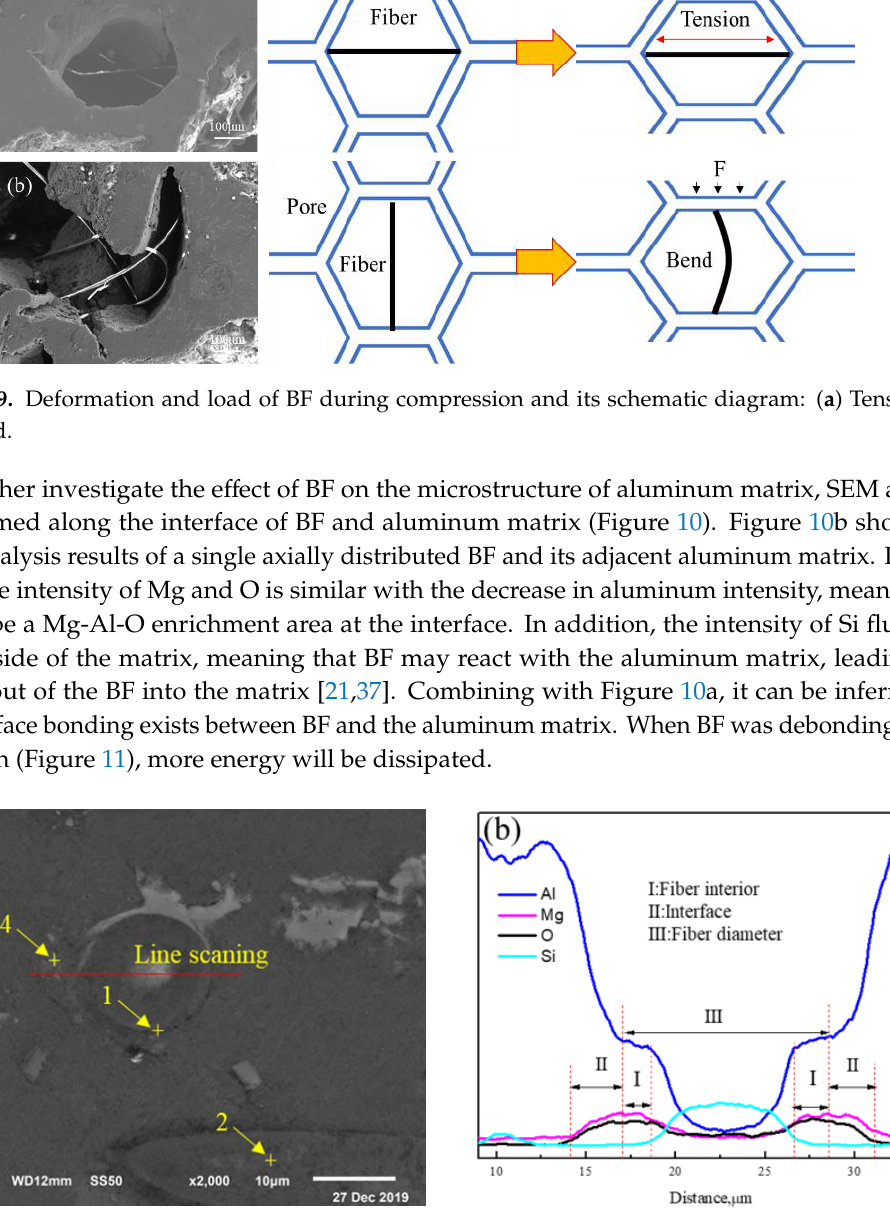
Figure 8. Failure morphology of BF-containing aluminum foam: ( a ) BF breaking simultaneously with the matrix; ( b ) necking phenomenon; ( c ) detail of (B) in ( b ).